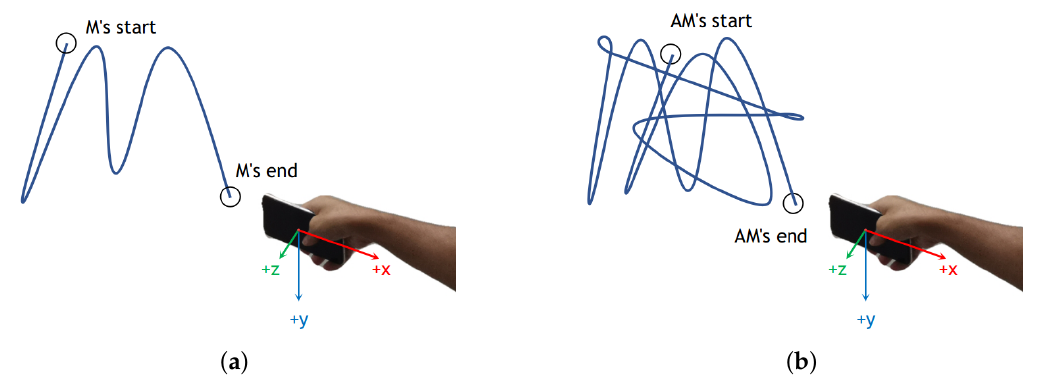
Figure 2. In-air handwriting system: ( a ) writing a character sample “M” in the air; ( b ) writing a word sample “AM” in the air. The red, blue, and green arrows refer to the x-axis, y-axis, and z-axis of the inertial sensor in the smartphone,